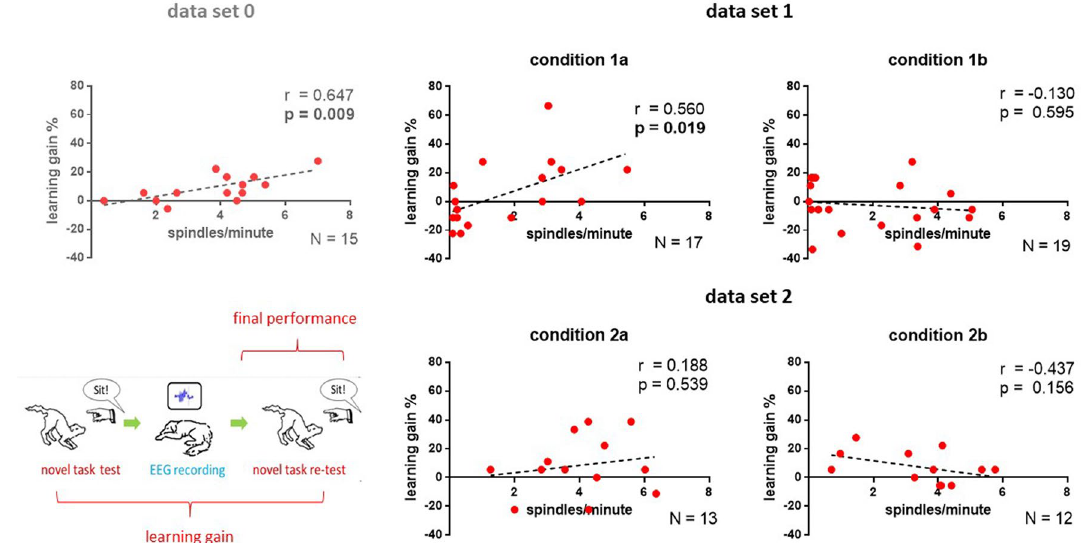
Figure 2. Associations between spindle density (spindles/minute) and learning gain as measured over the frontal midline electrode (Fz) in data sets 0, 1, and 2. For the already published finding in data set 0 9 we used lighter colors. Two dogs did not sleep in condition 1a and one dog did not sleep in condition 2b, these animals were excluded from the analysis. Schematic drawing (by the corresponding author) of how learning gain was calculated during tests on the novel